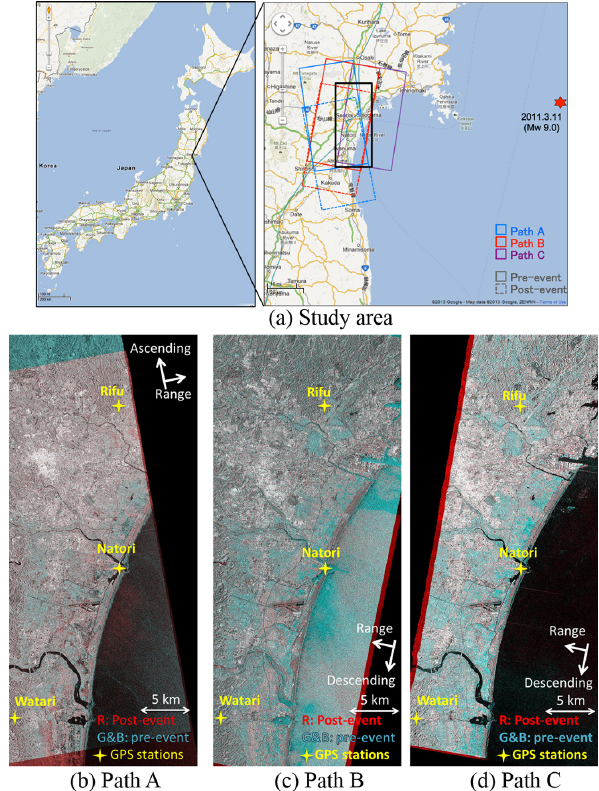
Figure 1. (a) Study area with the six TerraSAR-X images in Miyagi Prefecture. (b–d) Colour composites of the three pairs of pre- and post-event TSX images in paths A, B, and